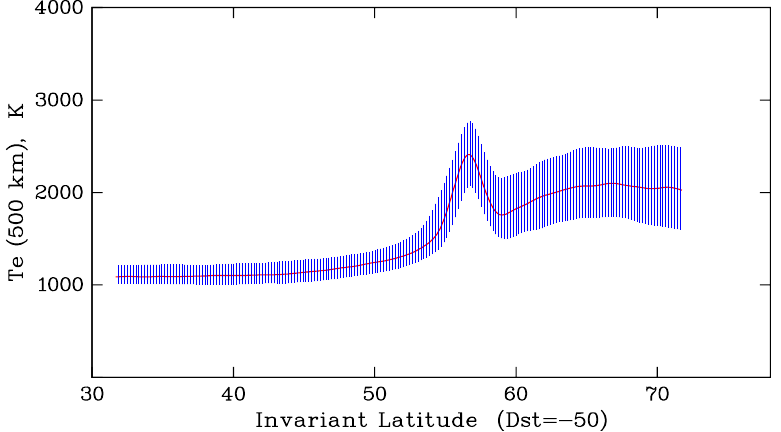
Fig. 12. Mean latitudinal profile of the subauroral electron temperature enhancement at an altitude of 500km. Plotted is the median of 841 temperature profiles. These profiles have been superimposed in such a way that the latitude of the temperature peak serves as a common reference location. The blue shaded area indicates the range between the lower and upper quartiles. Only data collected between 300 and 700km altitude were considered. All temperature values were adjusted to a common height of 500km using a constant temperature gradient of 1K/km. The latitudes indicated on the abscissa apply for a Dst index of − 50nT (see last paragraph of this section).